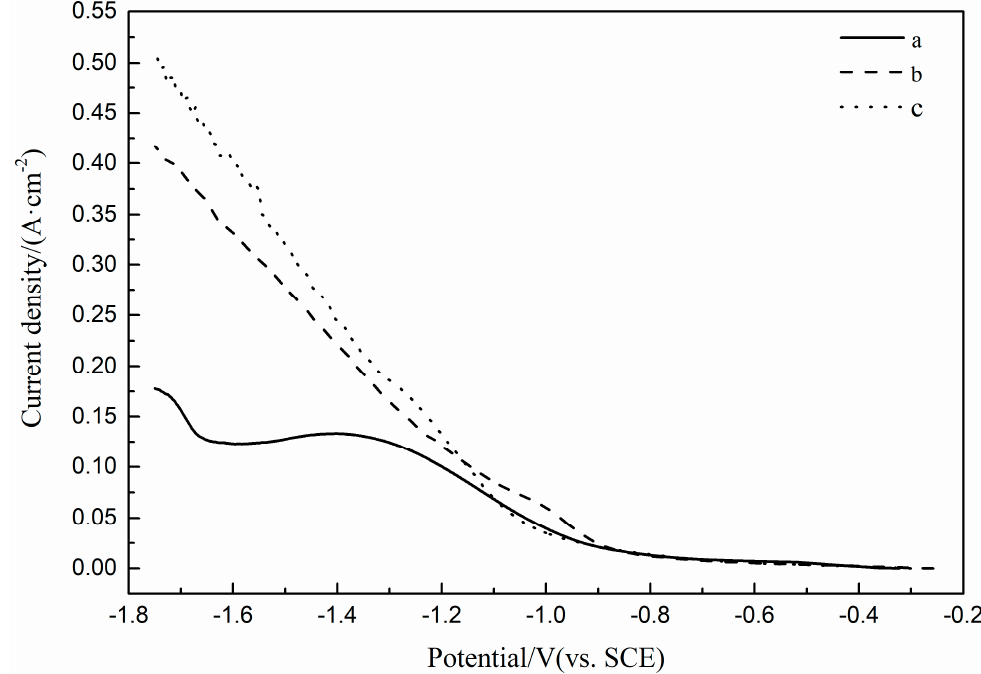
Figure 4. LSV curves of Pt electrode in H 2 SO 4 solution (pH=3): (a) 0.1M FeSO 4 and 0.1M NiSO 4 , (b) 0.1M FeSO 4 , 0.1M NiSO 4 and 0.15M (NH 4 ) 2 SO 4 , (c) 0.1M FeSO 4 , 0.1M NiSO 4 , 0.4M H 3 BO 3 and 0.15M (b) 0.1 M FeSO 4 , 0.1 M NiSO 4 and 0.15 M (NH 4 ) 2 SO 4 , (c) 0.1 M FeSO 4 , 0.1 M NiSO 4 , 0.4 M H 3 BO 3 (NH 4 ) 2 SO 4. and 0.15 M (NH 4 ) 2 SO 4